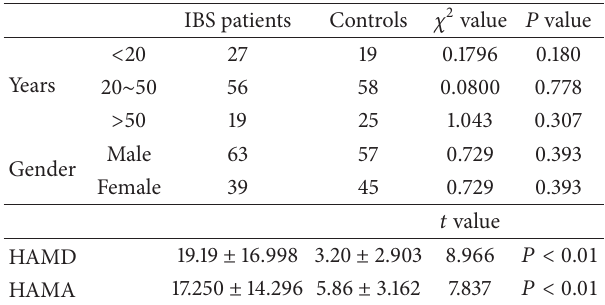
Table 1: Comparison of HAMD and HAMA scores in 102 patients with IBS and control